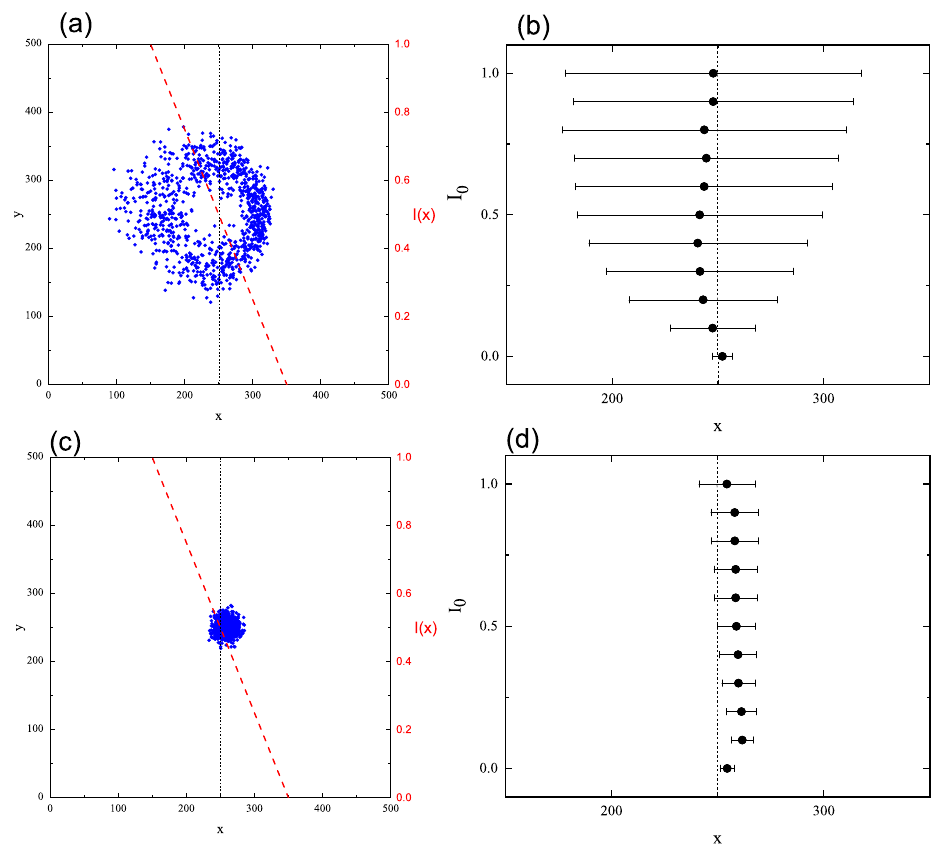
Figure 18. Final positions of CM of chains after 10 4 MCS for FP ( a ) and PI model ( c ) and averaged position of CM in x direction, with standard deviation σ x ( I 0 ) , for FP model ( b ) and PI model ( d ). Θ = 90 ◦ . T = 0.15, ∇ I = 0.005, I = 0